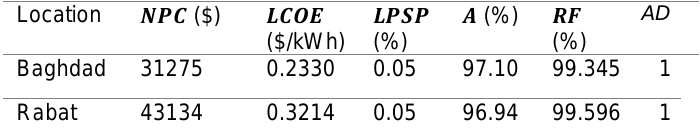
Table 9 . Factors